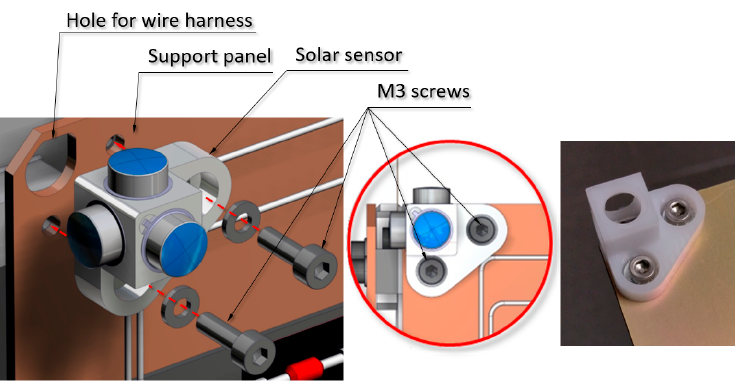
Figure 5. SS1 solar sensor assembly on the support panel attached using two M3 screws.